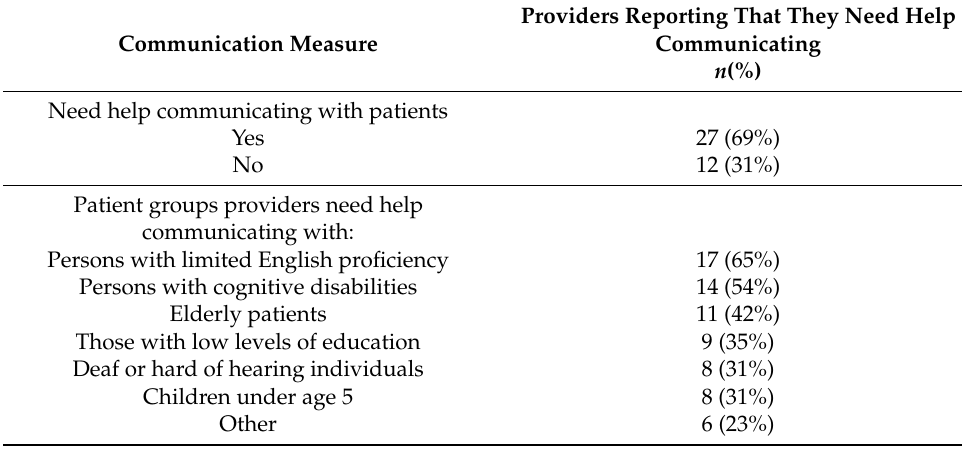
Table 4. Communication help needed for providers by type of patient/caregiver ( n =